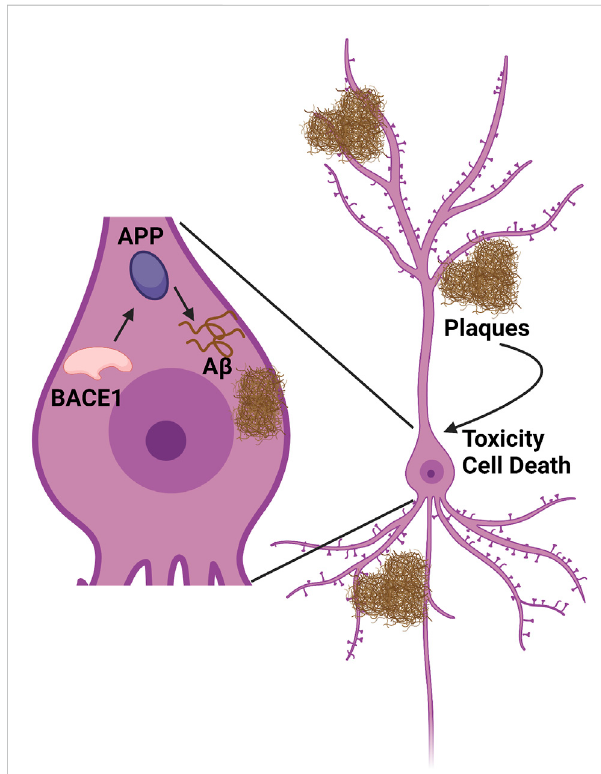
FIGURE 1 Amyloid synthesis cascade pathway. BACE1 cleaves APP to produce A β peptide. This peptideaccumulates both intracellularly and extracellularly into tangles/plaques, which inturn causein fl ammation, toxicity, and cell death. Figure created using www.